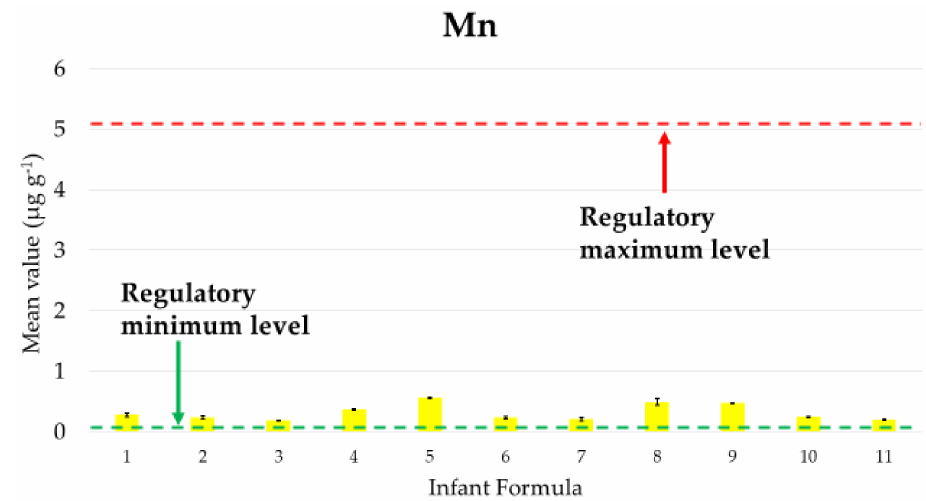
Figure 2. Mean values of the concentration, expressed in µ g g − 1 for each formula, of Mn. The black line on each bar represents the standard deviation; the green and red lines represent, respectively, the regulatory minimum and maximum